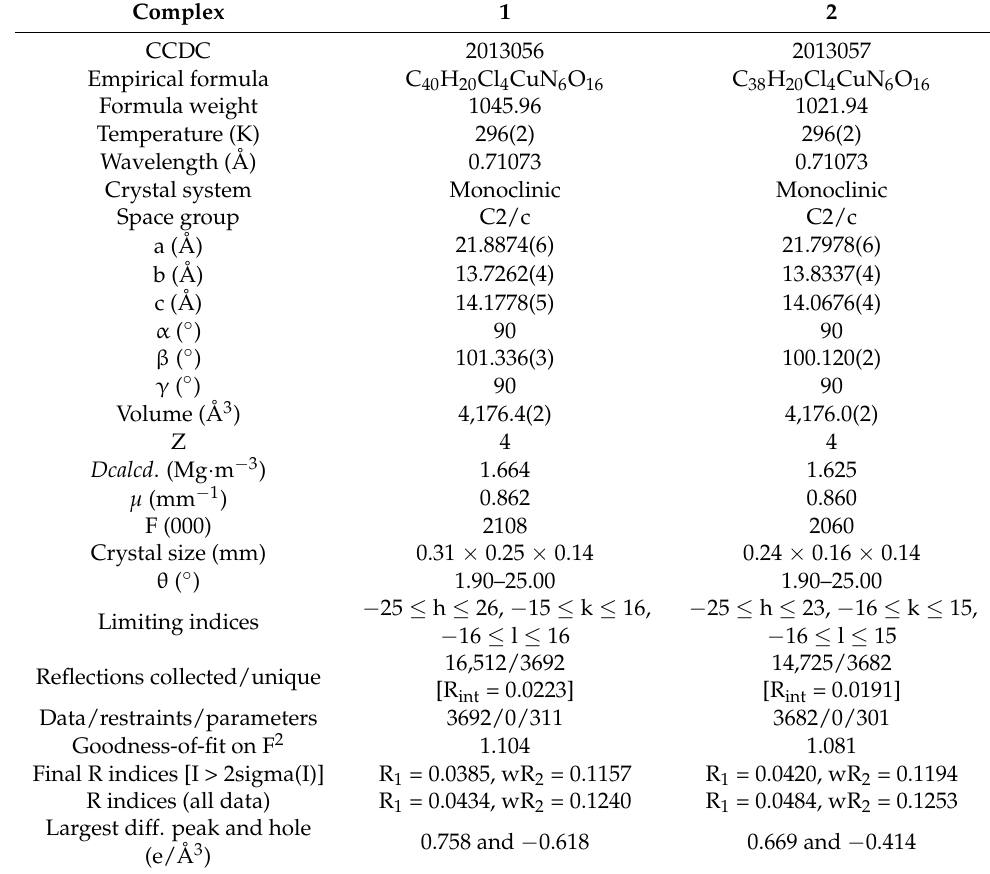
Table 1. Crystallographic data for complex 1 and complex 2